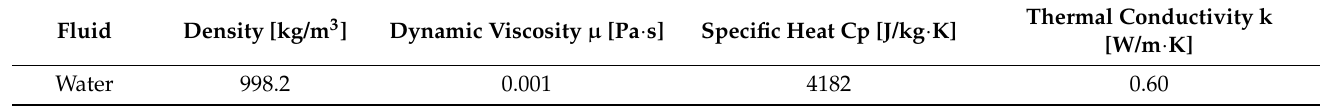
Table 2. Microchannel heat sinks (MCHS) (silicon): the thermophysical properties. Density ρ s Material